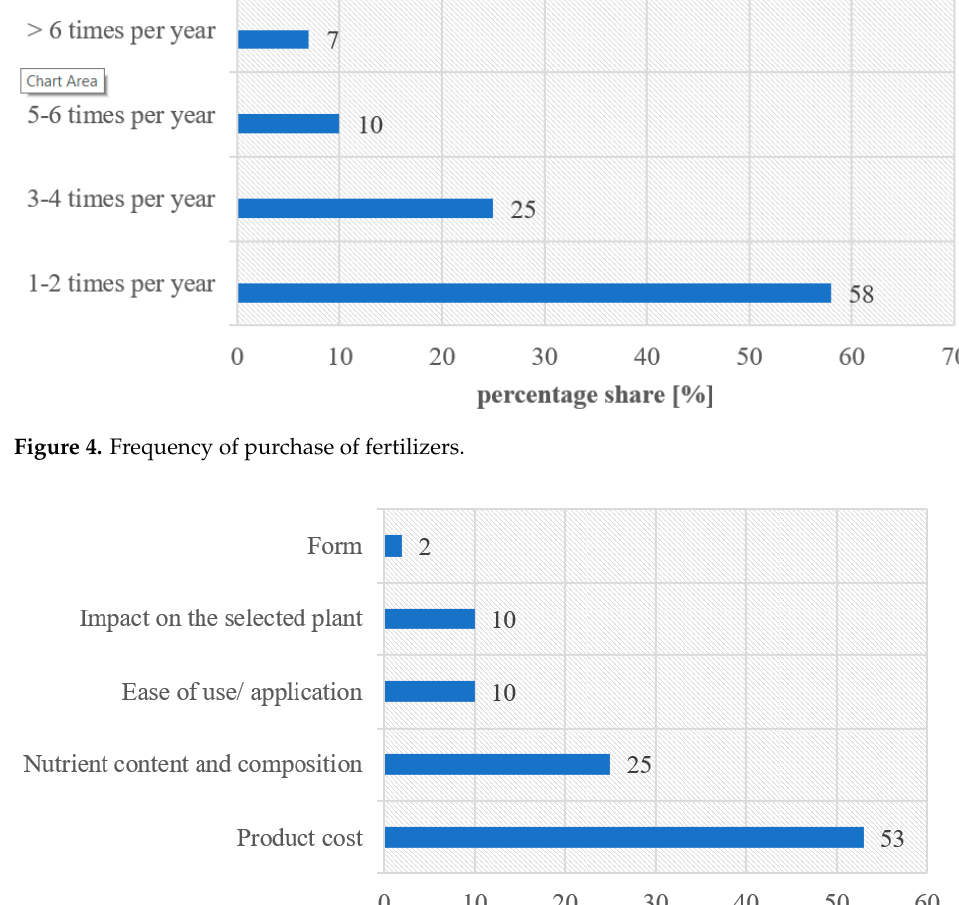
Figure 3. The types of fertilizer purchased.